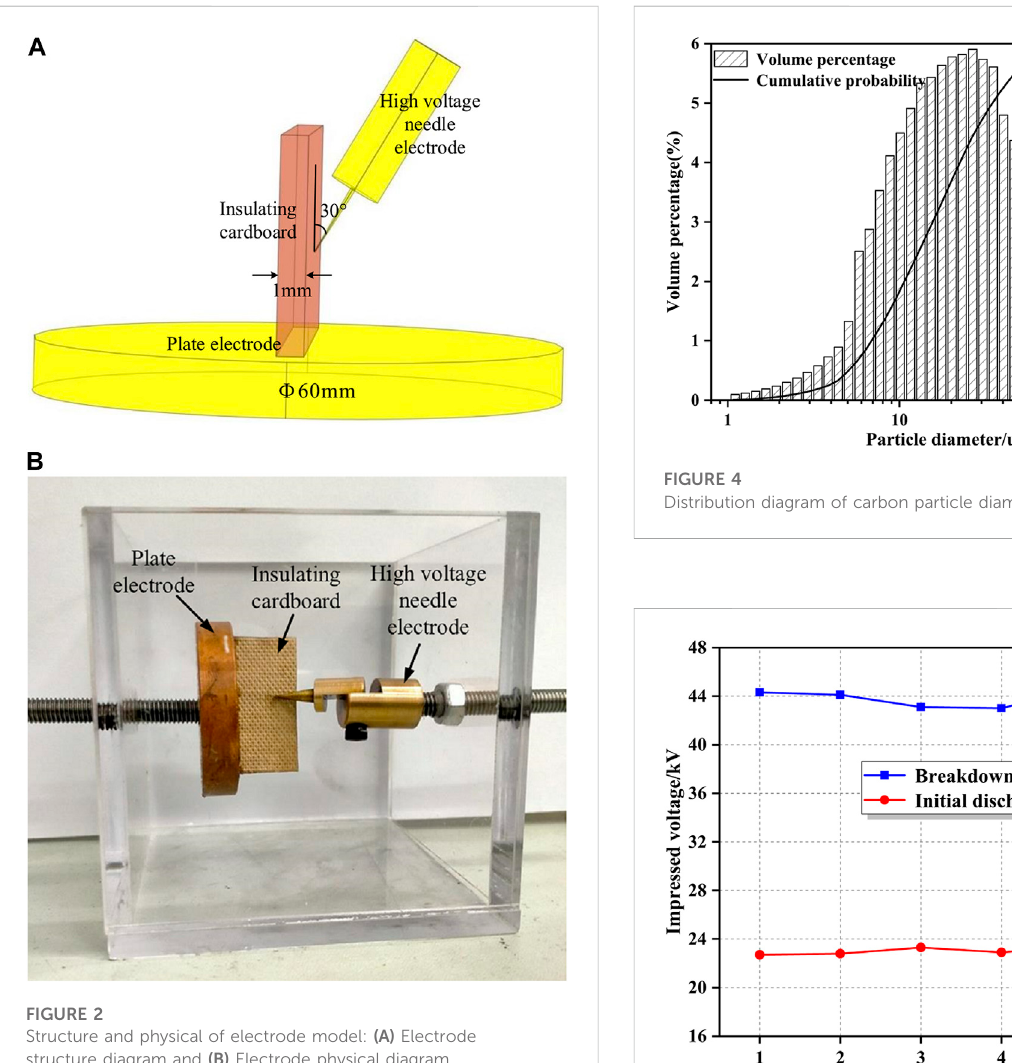
FIGURE 2 Structure and physical of electrode model: (A) Electrode structure diagram and (B) Electrode physical diagram.